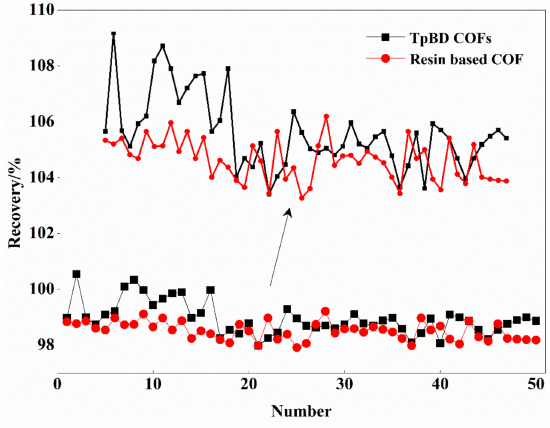
Figure 10. Recovery rate of SPE of